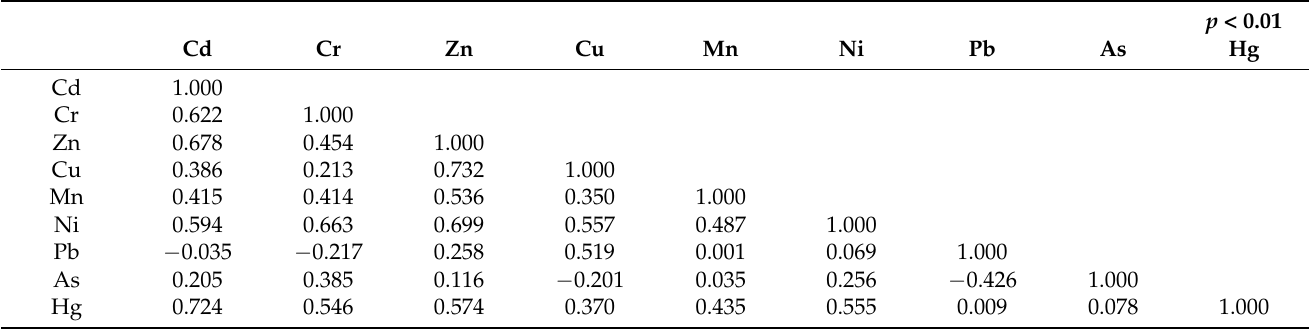
Table 1. Spearman correlation analysis of heavy metals in farmland soil of Shaanxi Province.